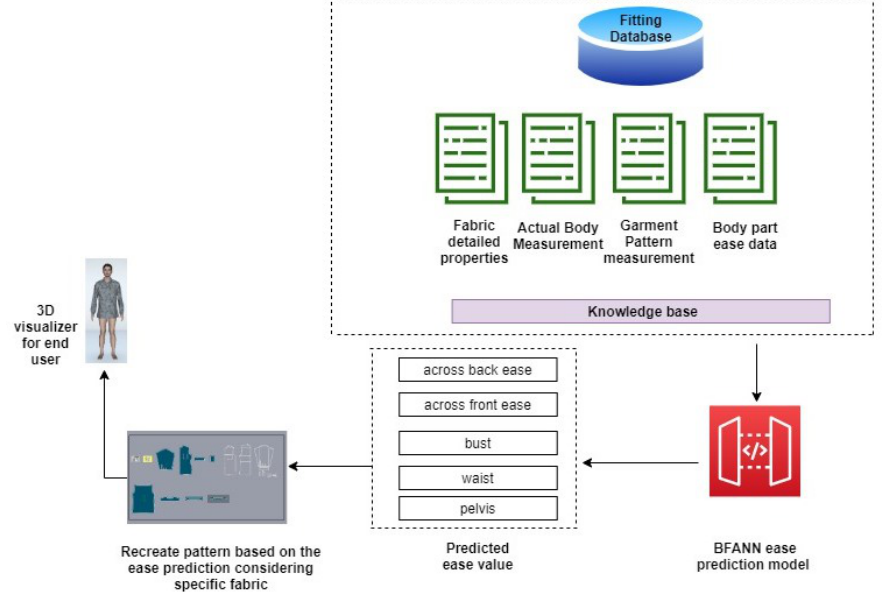
Figure 10. 3D ease prediction service